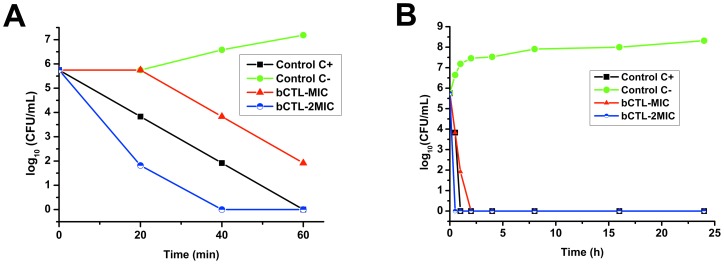
The bacterial killing kinetics of the bCTL against the S. aureus ATCC 25923.Different concentrations (MIC 40 µg/mL and 2× MIC 80 µg/mL) of bCTL were used. C+, represents antibiotic control (Cefotaxime 0.1 µg/mL + Tetracycline 10 µg/mL) and C-, represents phosphate buffer saline control. (A): S. aureus killing kinetics at time zero to 60 min. (B): S. aureus killing kinetics over 24 h time period.